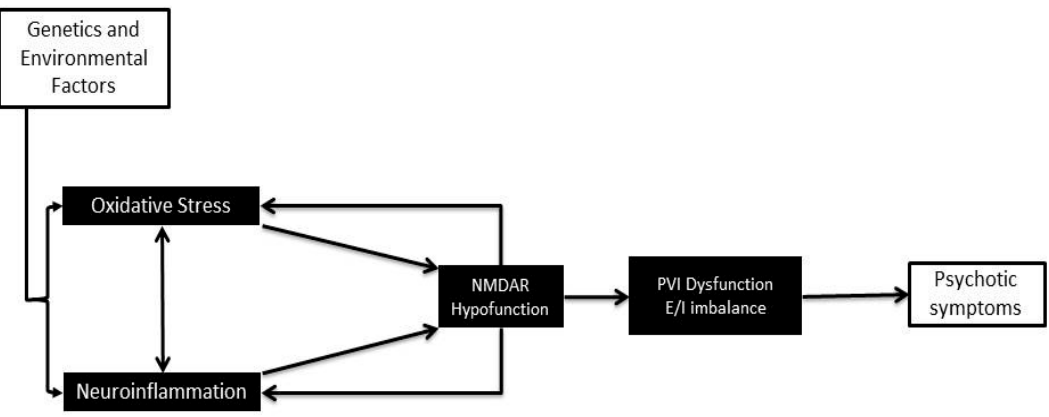
Figure 1. A simplified model of the link between neuroinflammation, oxidative stress and psychosis.